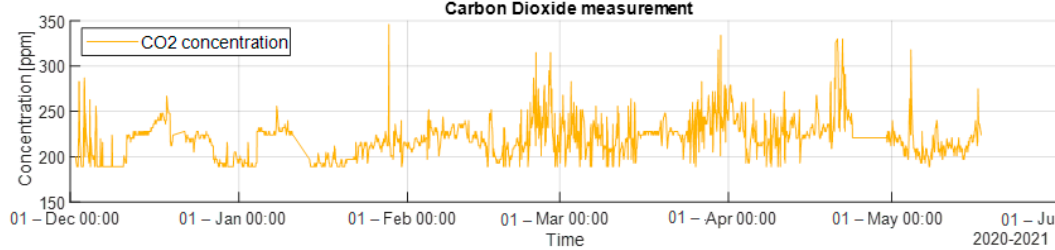
Figure 18. Carbon dioxide (CO 2 ) concentration within the experimental module.